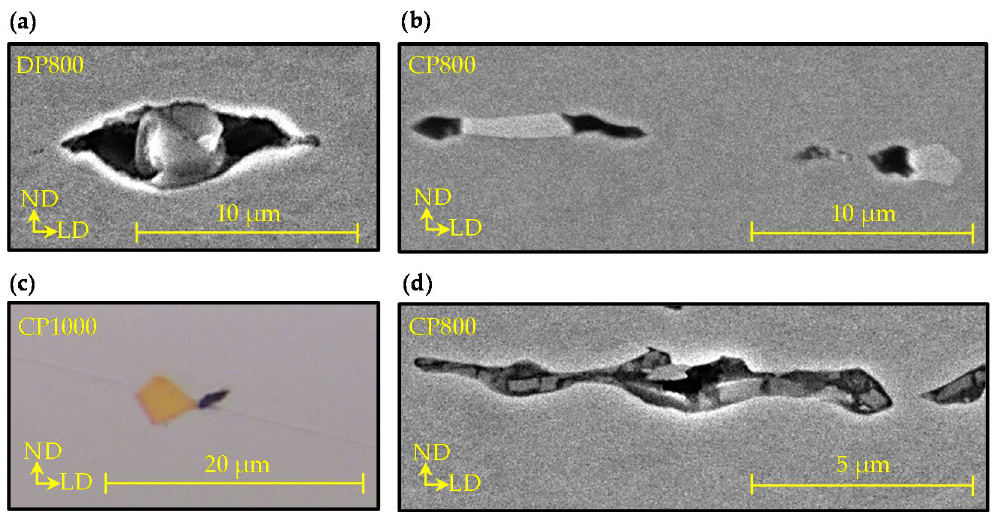
Figure A4. Examples for damage nucleation at inclusions: ( a ) aluminium oxide; ( b ) niobium carbide; ( c ) titanium carbide; ( d ) manganese sulfide.